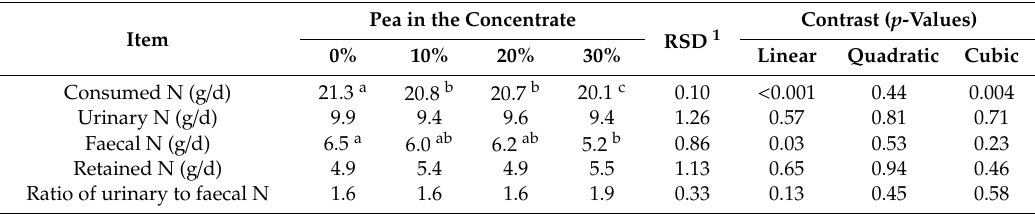
Table 3. E ff ect of the inclusion of pea in the concentrate on nitrogen (N) balance in lambs (in vivo digestibility